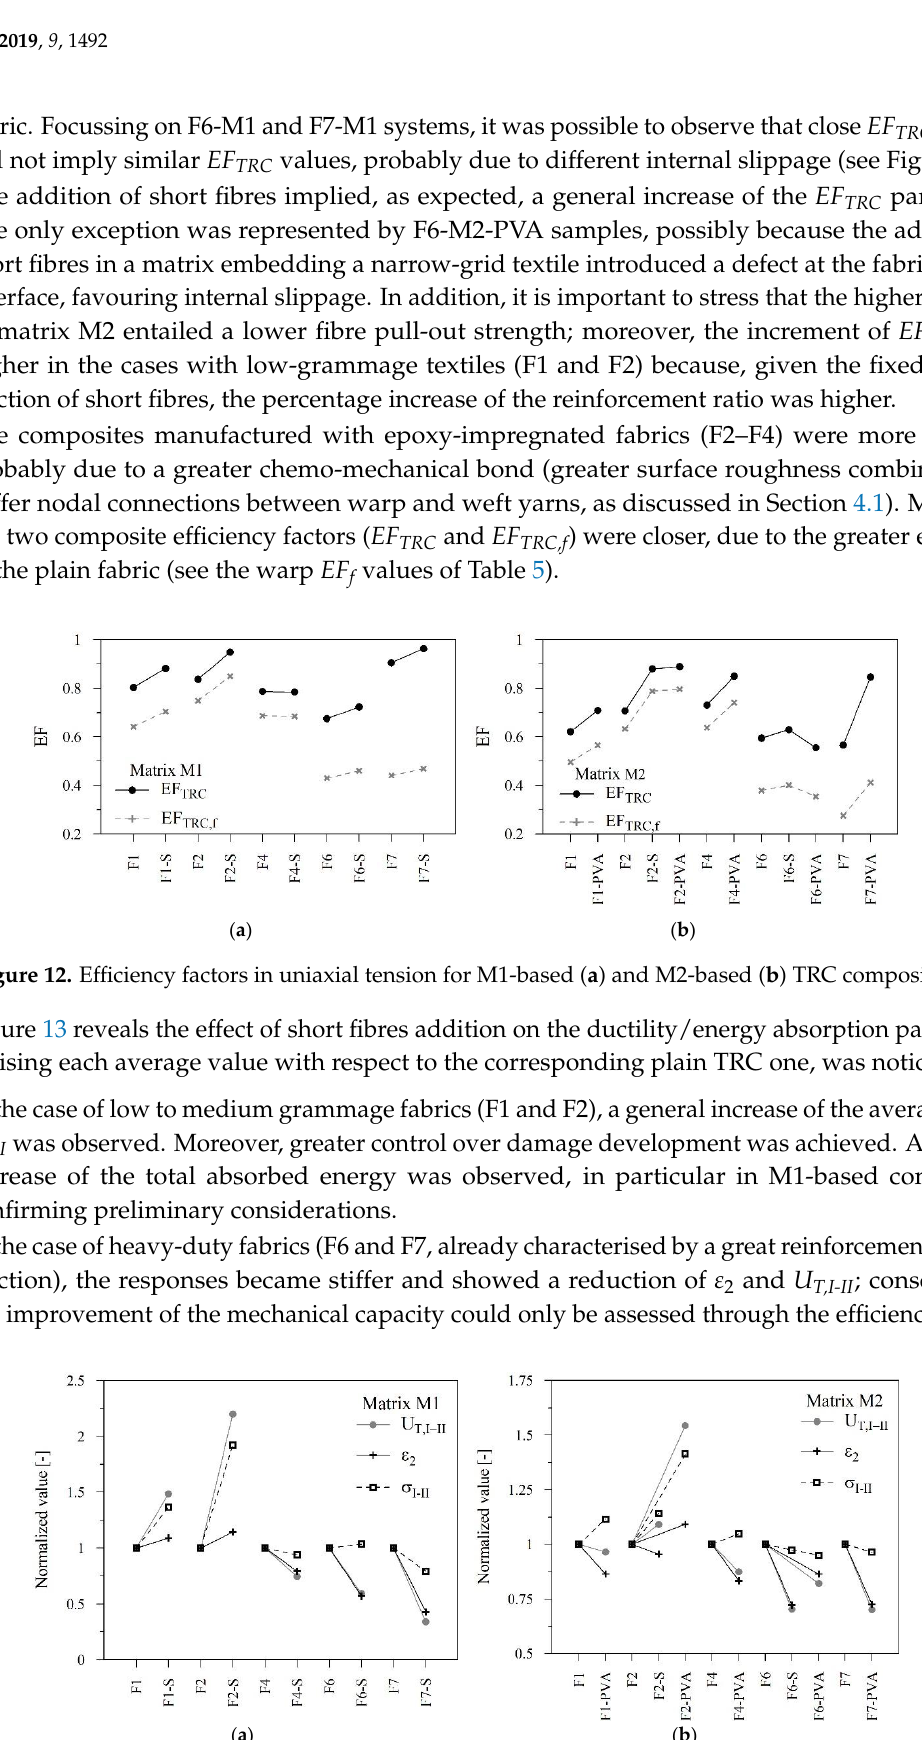
Figure 13. Ductility/energy absorption parameters in uniaxial tension for M1-based ( a ) and M2-based ( b ) TRC composites: effect of fibres addition.